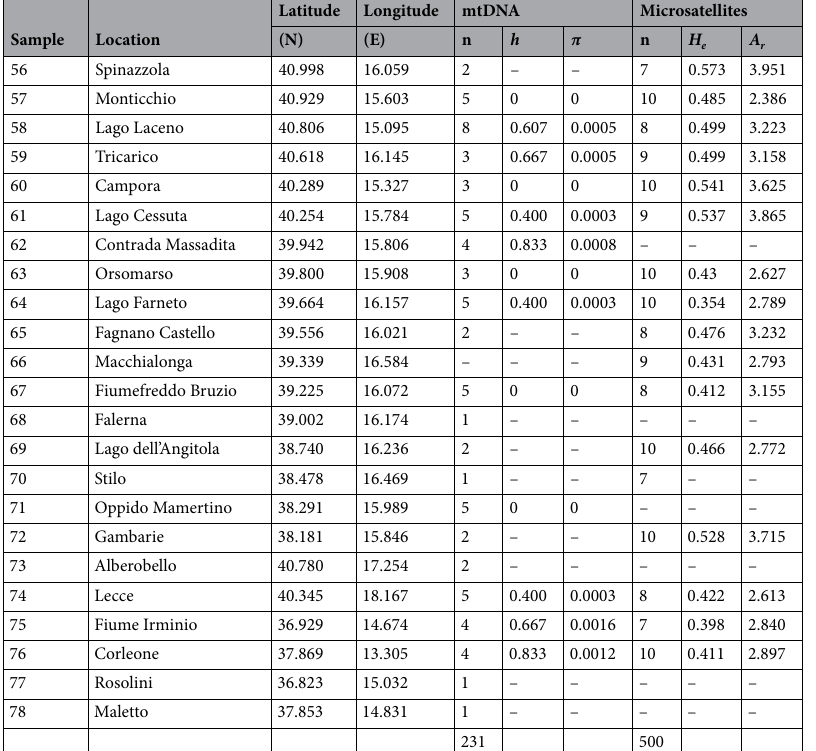
Table 1. Geographic locations, sample size (n), and estimates of genetic diversity for the 78 populations of Bufo bufo analysed in this study. h : haplotype diversity; π : nucleotide diversity; H e : expected heterozygosity; A r ; allelic